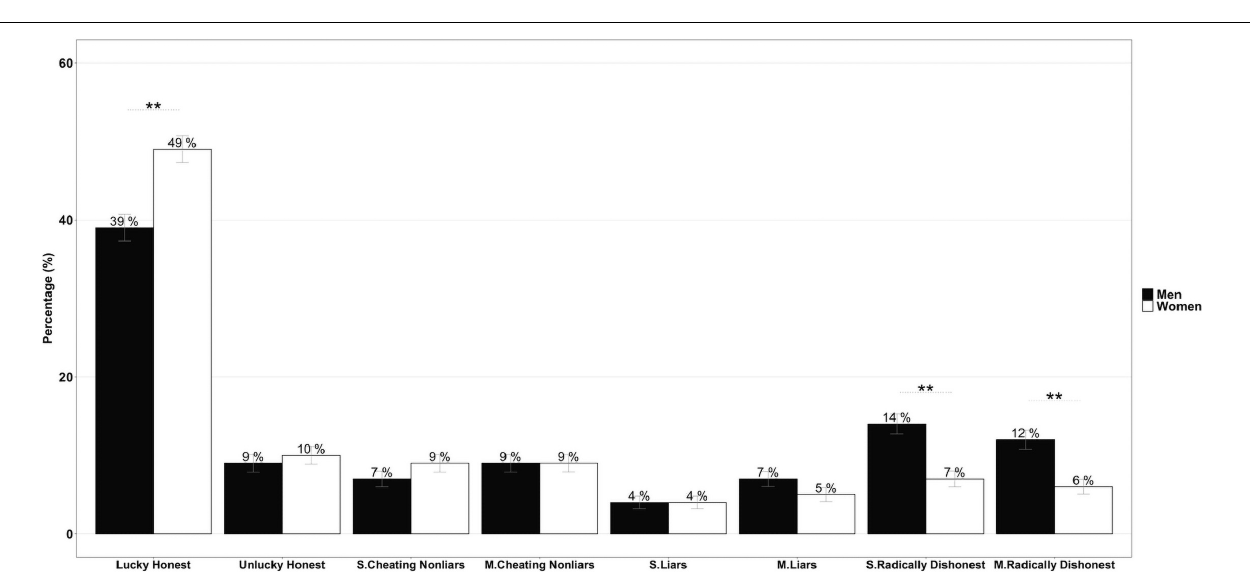
FIGURE 3 | Percentage of men (black) and women (white) for each (dis)honesty profile. Note that lucky people achieving an outcome “5” were excluded from the analysis. In contrast, honest people included here are those achieving an outcome other than “5”; S., sub-maximizing and M., maximizing. The number above bars indicates the percentage; asterisks indicate significance in pairwise proportion comparisons: ** p <